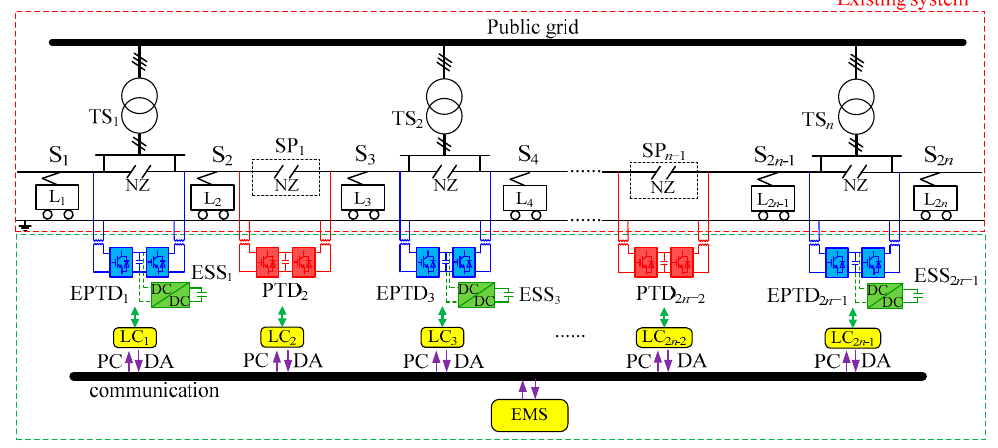
Figure 1. The modified railway system. TS: traction substations; SP: section posts; S: section; L: load;